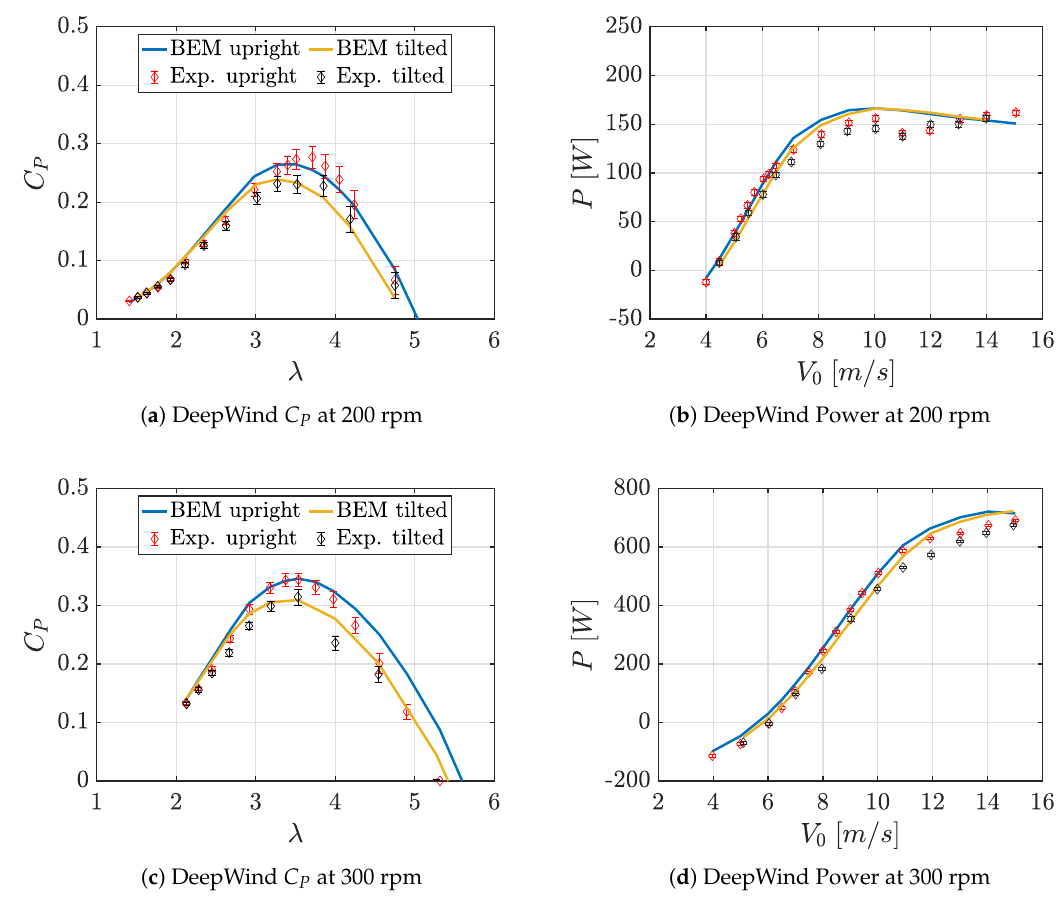
Figure 8. DeepWind